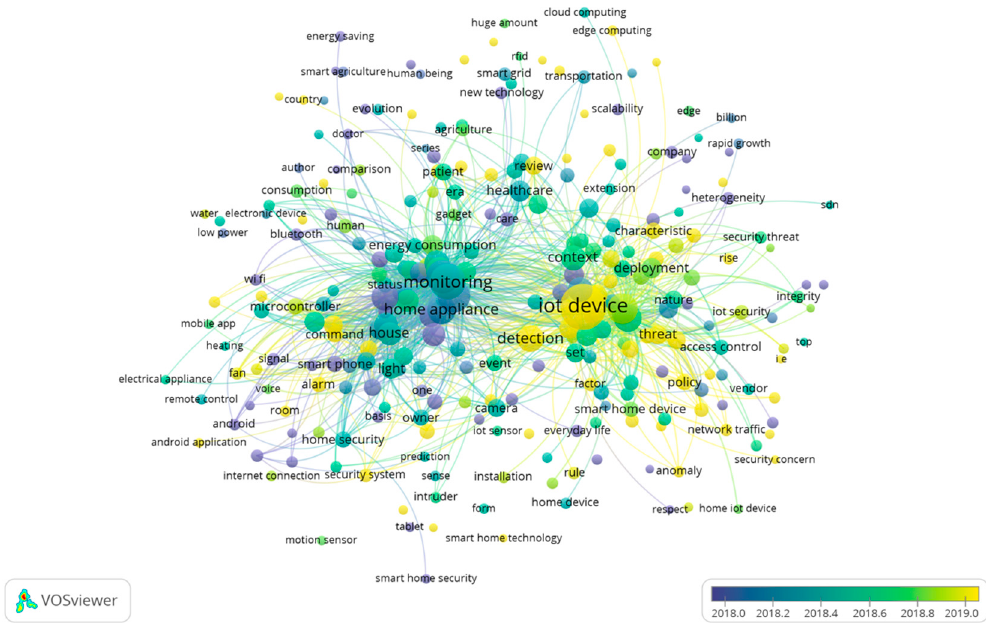
Figure 10. Themes overlay for 2018.